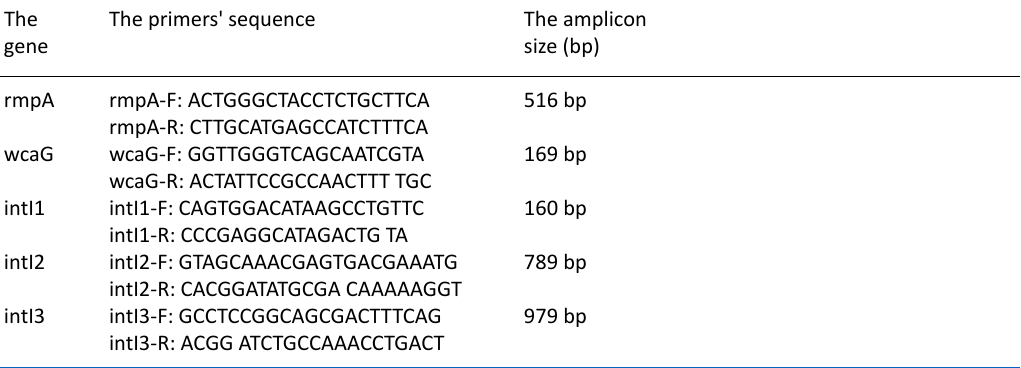
table 1. Primers used for the amplification of the five virulence genes 9